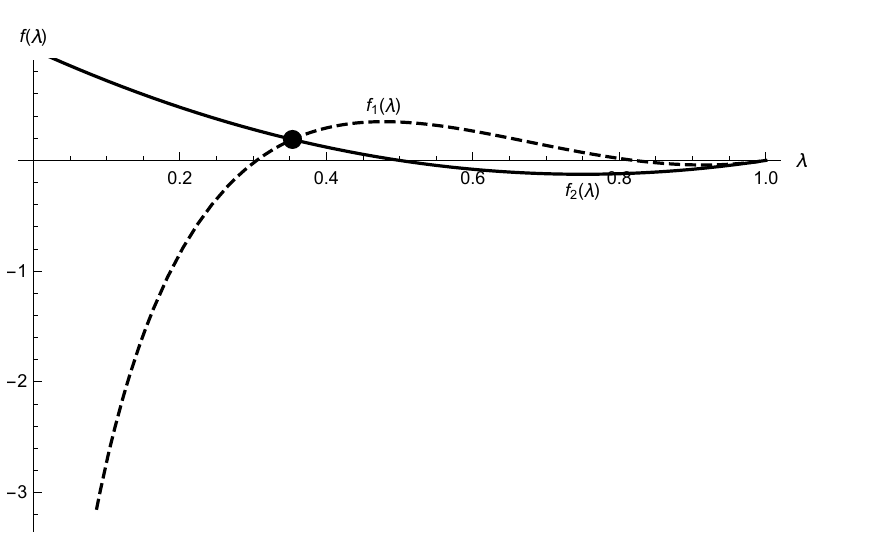
Figure 1. Graphical solution of the inequality f 1 ( λ ) > f 2 ( λ ) , where f 1 ( λ ) = ( 8 λ 2 − 9 λ + 2 ) log ( λ ) and f 2 ( λ ) = 2 λ 2 − 3 λ +